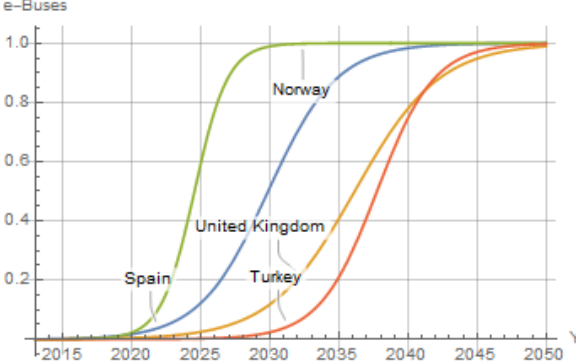
Figure 5. The cumulative Bass curves for Spain, the United Kingdom, Norway, and Turkey [own